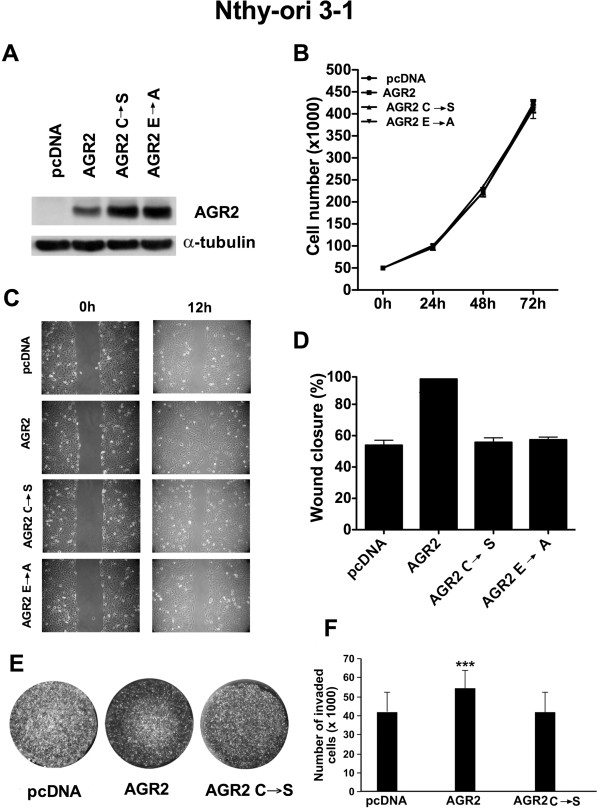
Effects of AGR2 ectopic expression on Nthy-ori 3–1 cell growth, migration and invasion. A) Expression levels of AGR2, AGR2 (C → S) and AGR2 (E → A) in transfected Nthy-ori 3–1 cells: after G418 selection, cells were lysed and analyzed by Western blotting with the indicated antibodies. B) Nthy-ori 3–1 cells transfected with AGR2, AGR2 (C → S), AGR2 (E → A) or empty vector (pcDNA) were plated and counted at different time points. Values represent the average of triplicate experiments ± standard deviations. C) A wound was introduced on confluent monolayer of Nthy-ori 3–1 cells transfected with AGR2, AGR2 (C → S), AGR2 (E → A) and vector control (pcDNA) and wound closure was monitored at 12 hours time points. D) Wound closure was measured by calculating pixel densities in the wound area and expressed as percentage of wound closure of triplicate areas ± standard deviations. E) Nthy-ori 3–1 cells transfected with AGR2, AGR2 (C → S) or the empty vector (pcDNA) were seeded in the upper chamber of transwells and incubated for 24 hours; the upper surface of the filter was wiped clean and cells on the lower surface were stained and counted. F) Invasive ability was expressed as number of invaded cells. Values represent the average of triplicate experiments ± standard deviations. Asterisks indicate P < 0.001 (***).